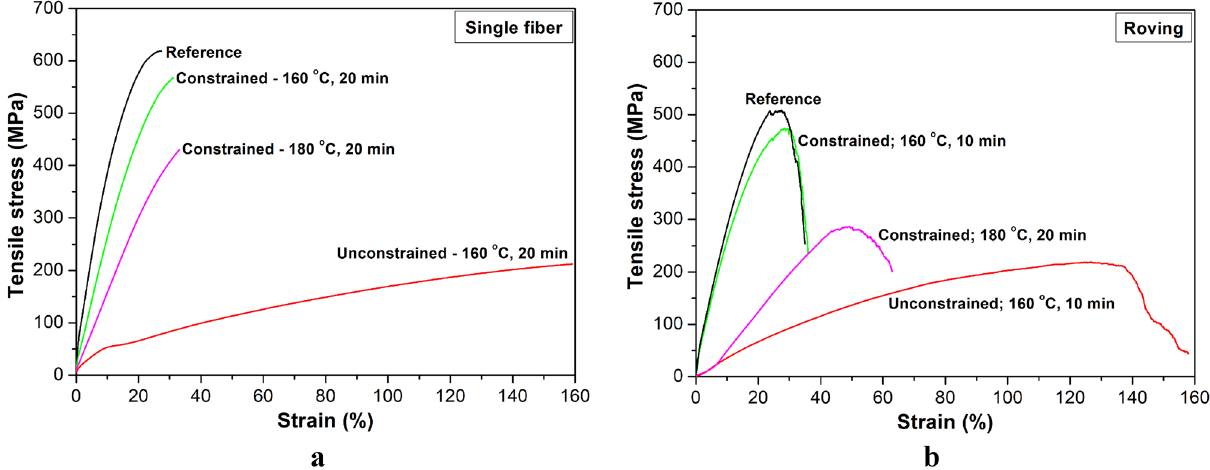
Figure 4. Typical stress–strain curves of single fibers ( a ) and rovings ( b ) for untreated and heat-treated fibers ( b ) at different treatment